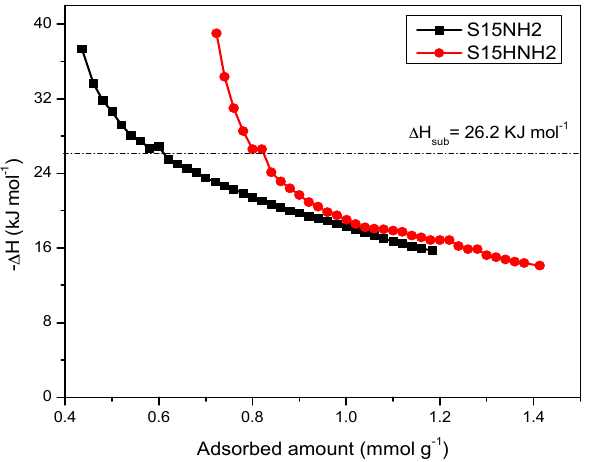
Figure 18. CO 2 enthalpy of adsorption of the APTES functionalized SBA-15 substrates ((pristine and previously treated SBA-15).